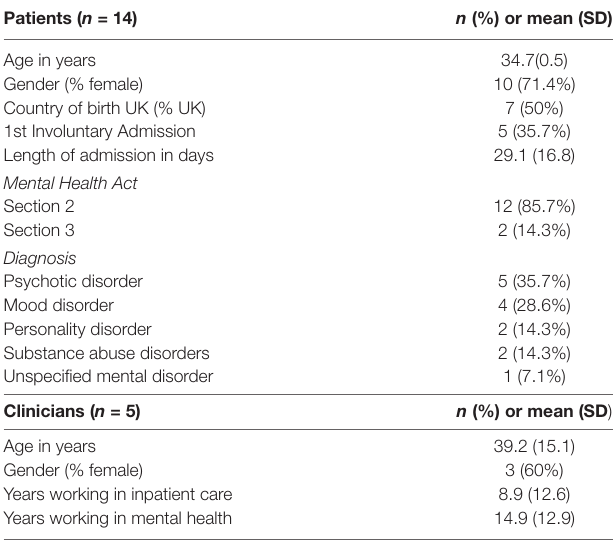
TABLE 1 | Sociodemographic and clinical characteristics of participants.